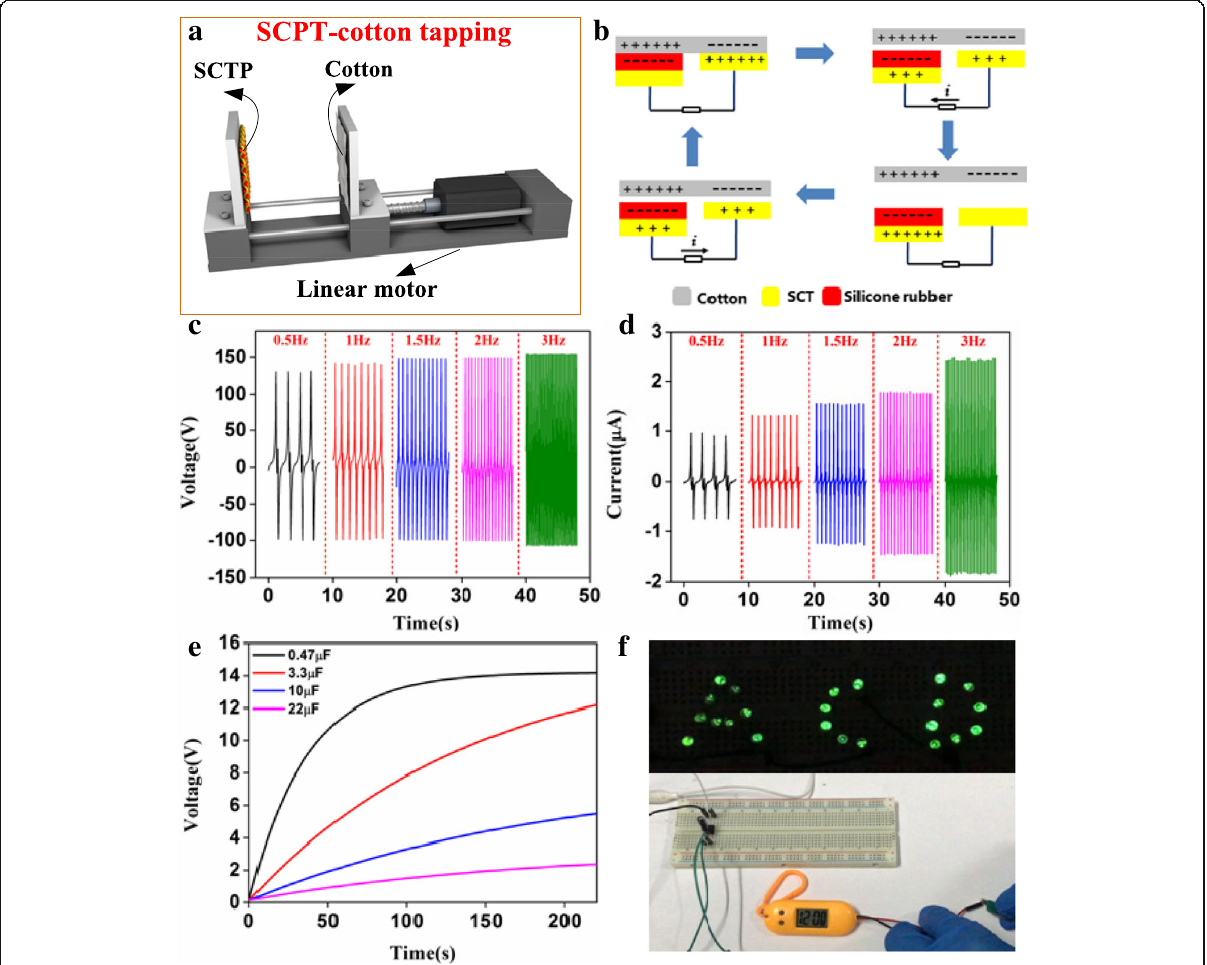
Fig.4 a The schematic illustration of the SPST-cotton tapping. b The electricity generation mechanism with SPST-cotton tapping. c The open-circuit voltages and d short-circuit currents with SPST-cotton tapping at different tapping frequencies. e Measured voltage curves of various capacitors at frequency of 3 Hz and force of 100 N. f The LEDs and electric watch were driven by the SPST-cotton